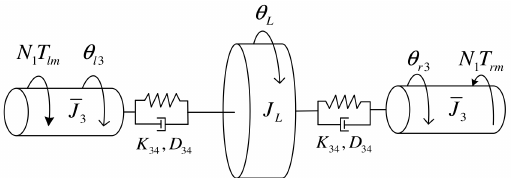
Figure 10. The simplified overall linear model of the